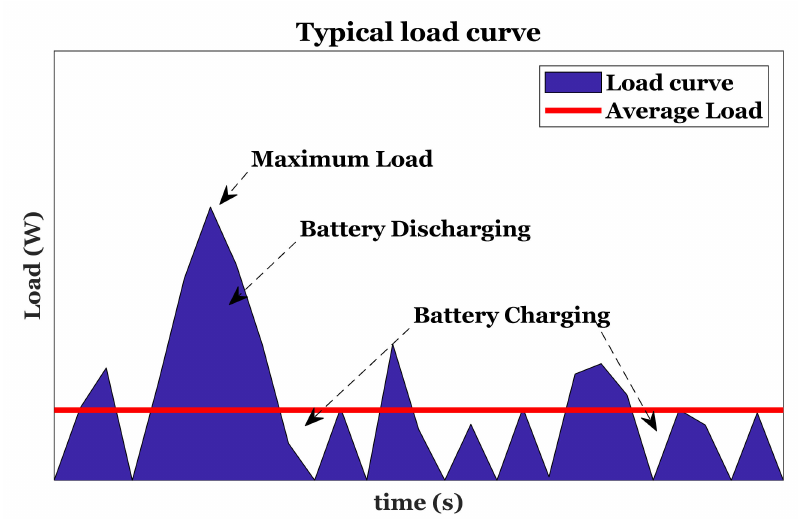
Figure 5. Decomposing of typical driving